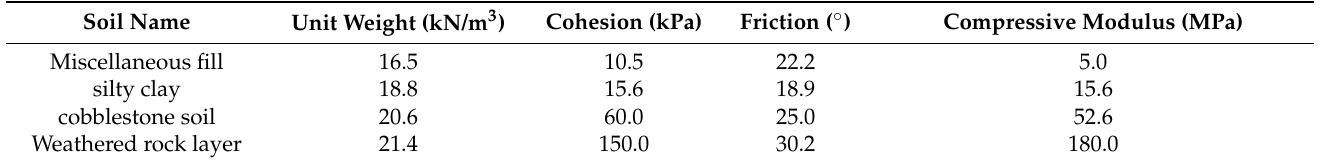
Table 1. Mechanical parameters of soil strata.